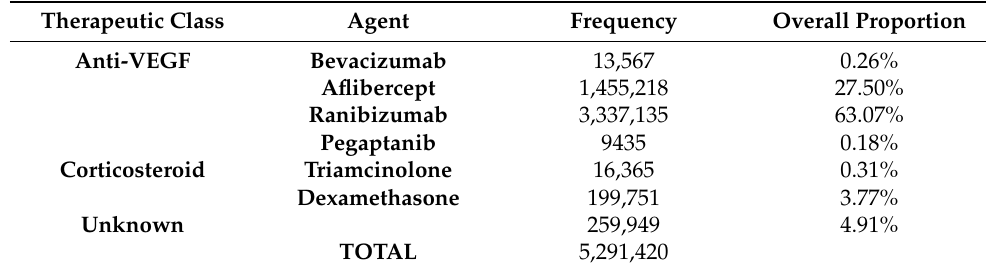
Table 2. Proportion of IVT